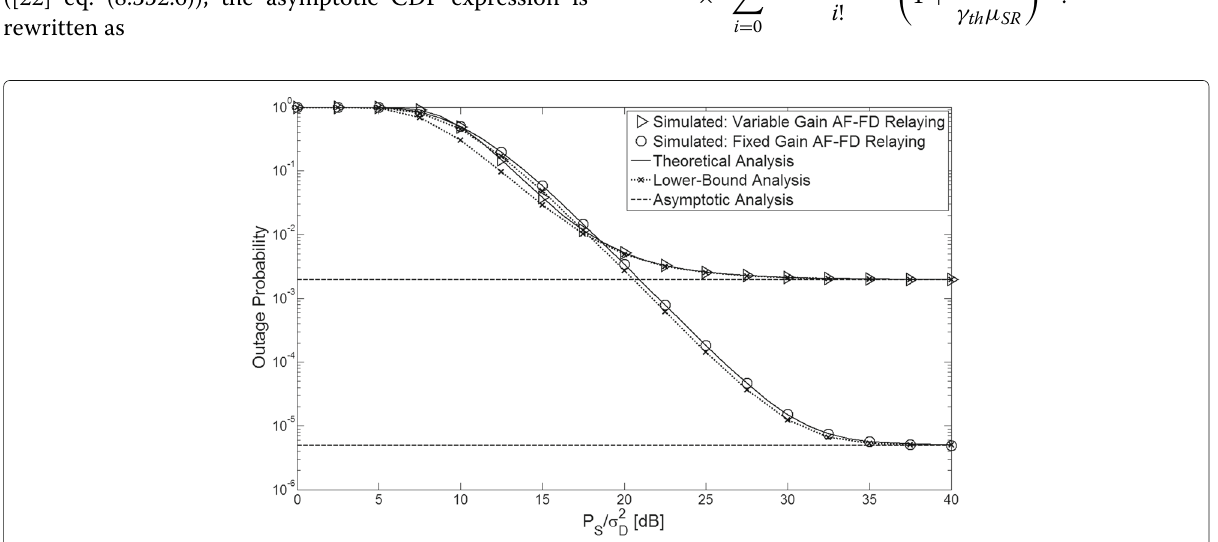
Fig. 5 Outage probability of the fixed-gain and variable-gain AF-FD systems for 2 P S = 3 P R , (cid:6) SR = 1, (cid:6) RD = 2, (cid:6) LI = 0.025, m SR = 4, m RD = 2.5, m LI = 1 and γ th =